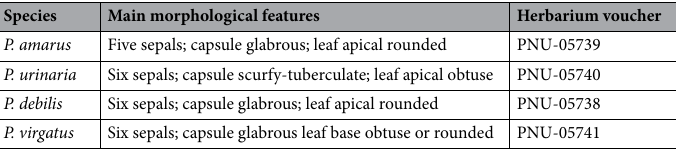
Table 1. Main morphological features and herbarium vouchers of Phyllanthus used in this